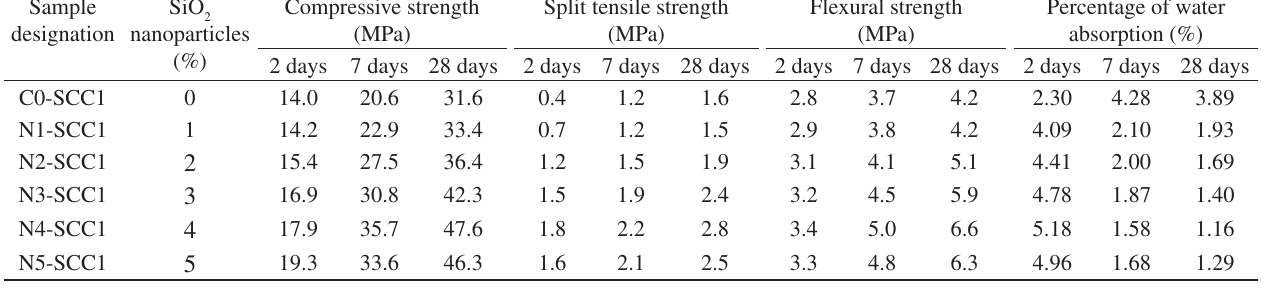
Table 5. Strength assessments and water permeability of C0-SCC and N-SCC specimens. Sample